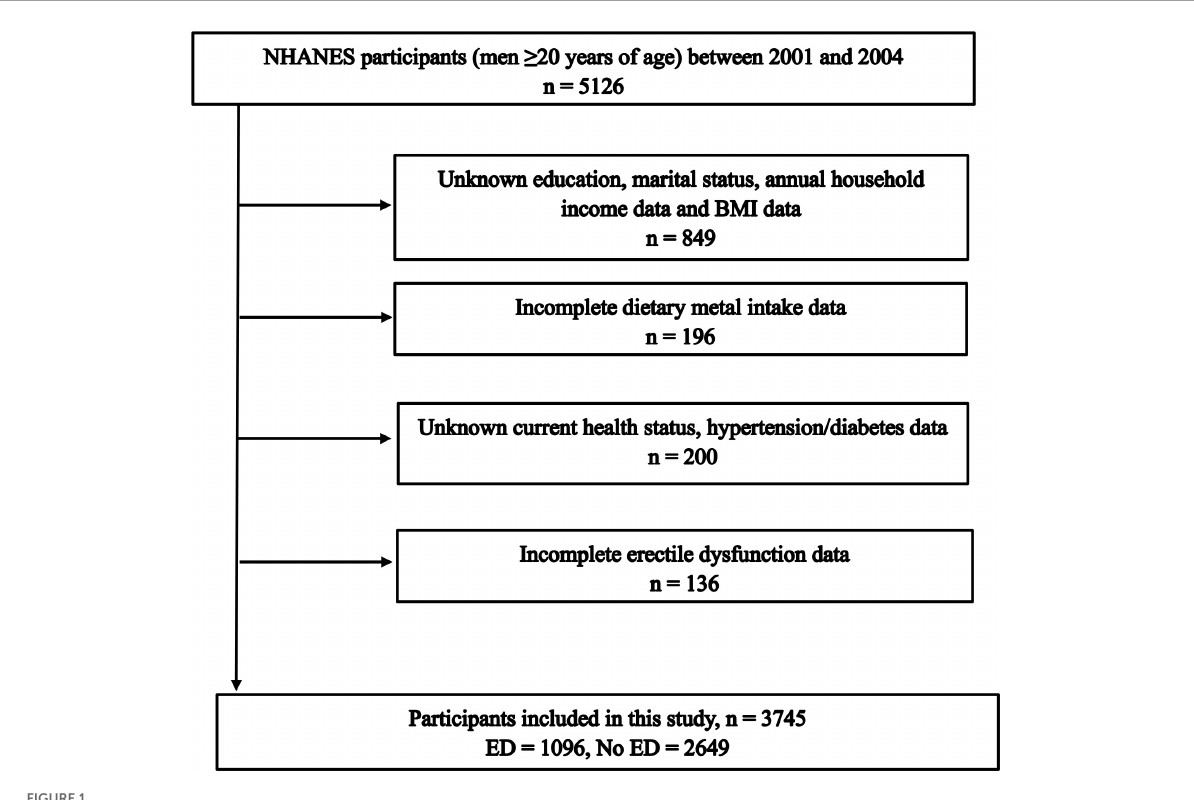
FIGURE1 Flow chart of the study population